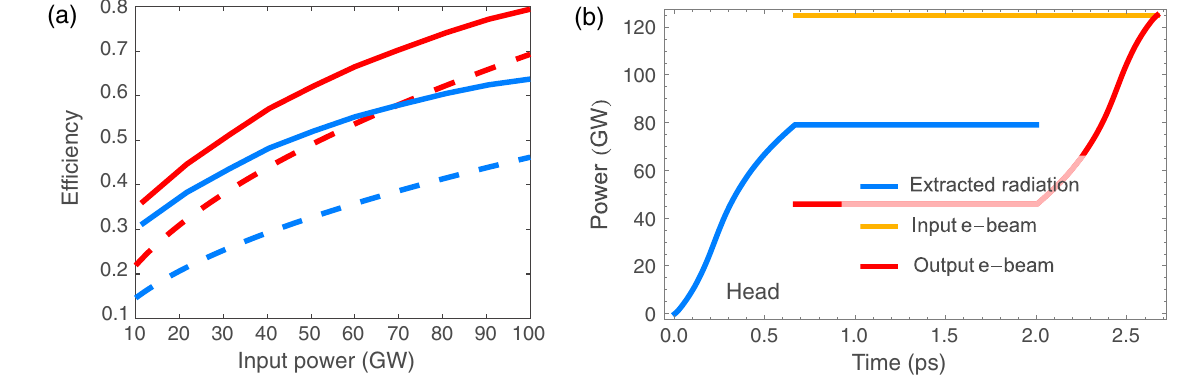
FIG. 7. (a) Peak power (blue) and energy (red) efficiency from the GITS simulation results. The theoretical estimates η e and η e · η s for a constant period case with N w ¼ 200 are also shown for reference. (b) Time-domain view of the beam and radiation power at the entrance and exit of the